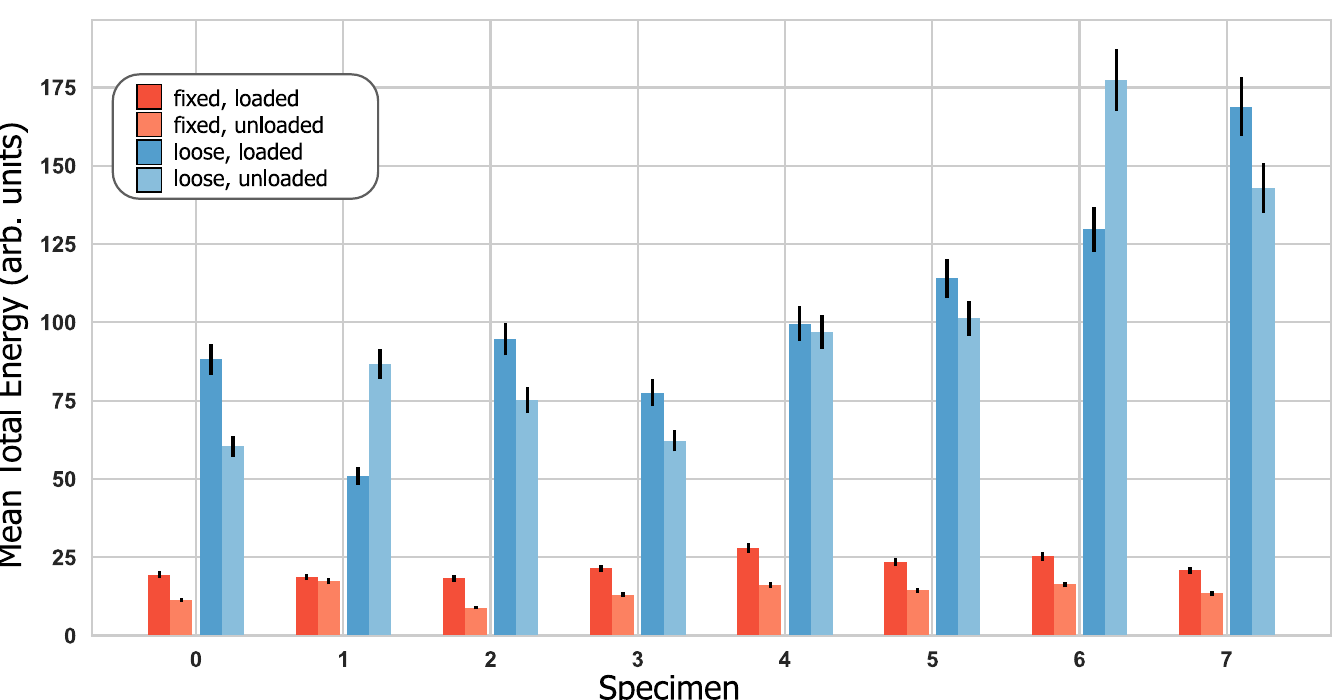
Fig 6. Mean total signal energy for the implant sensor with the error bars depicting the estimated uncertainty. The corresponding ROC-AUC values were 1.0 (loaded) and 1.0 (unloaded).